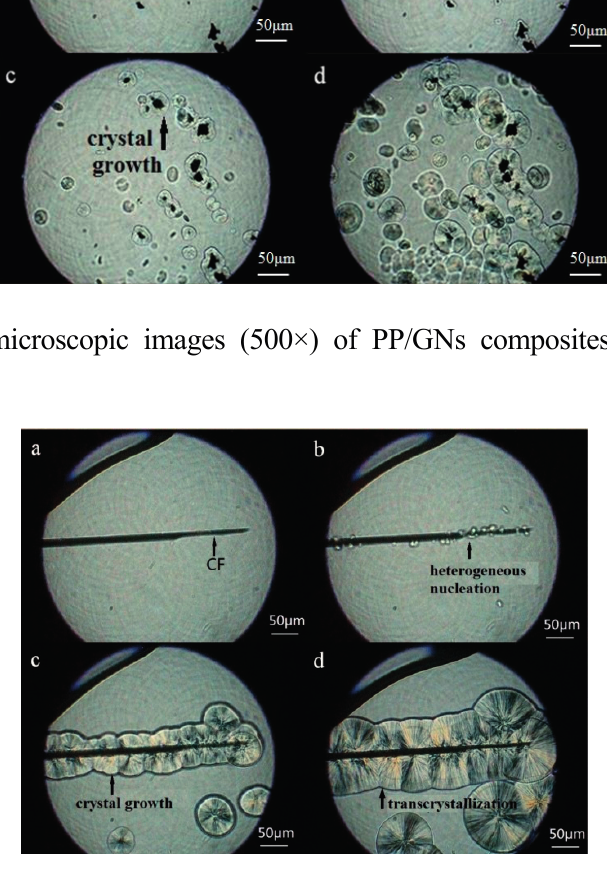
Figure 4. Optical microscopic images (500×) of PP/CF composites at ( a ) 200 °C and ( b – d ) near 130